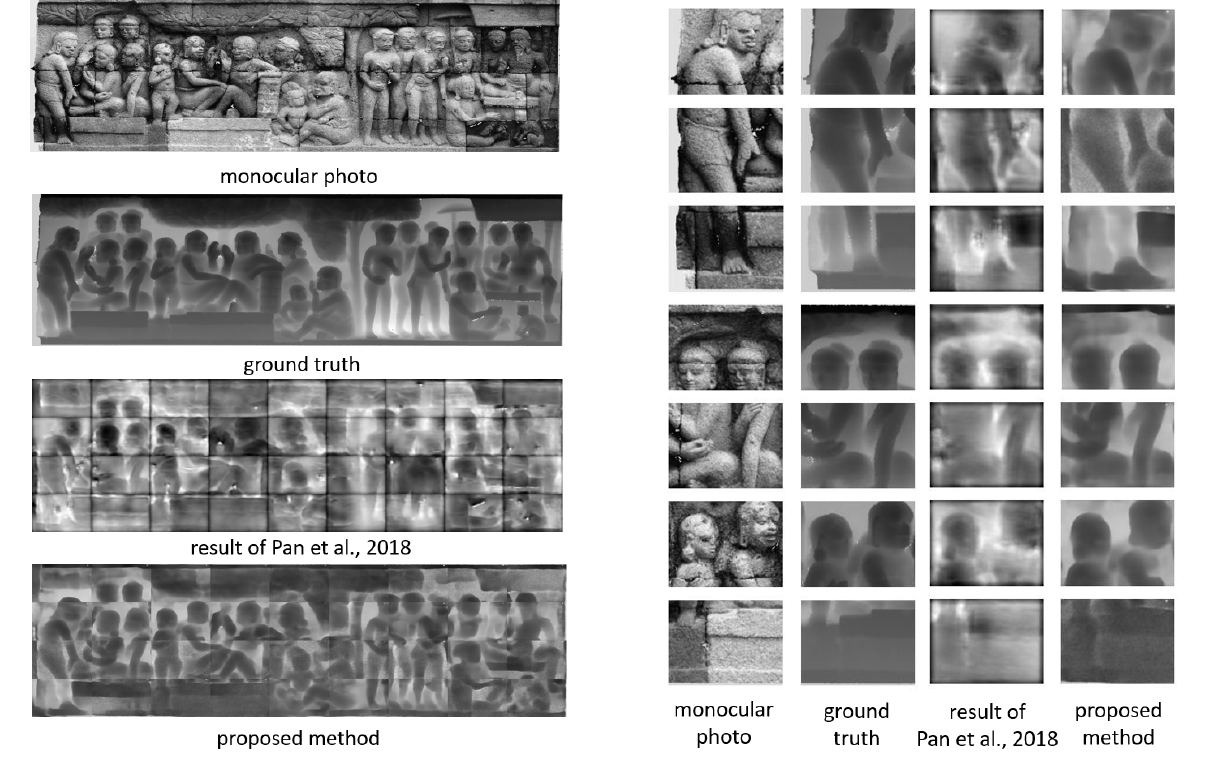
Figure 5. Depth estimation result. Figure 6. Patch-wise depth estimation result.